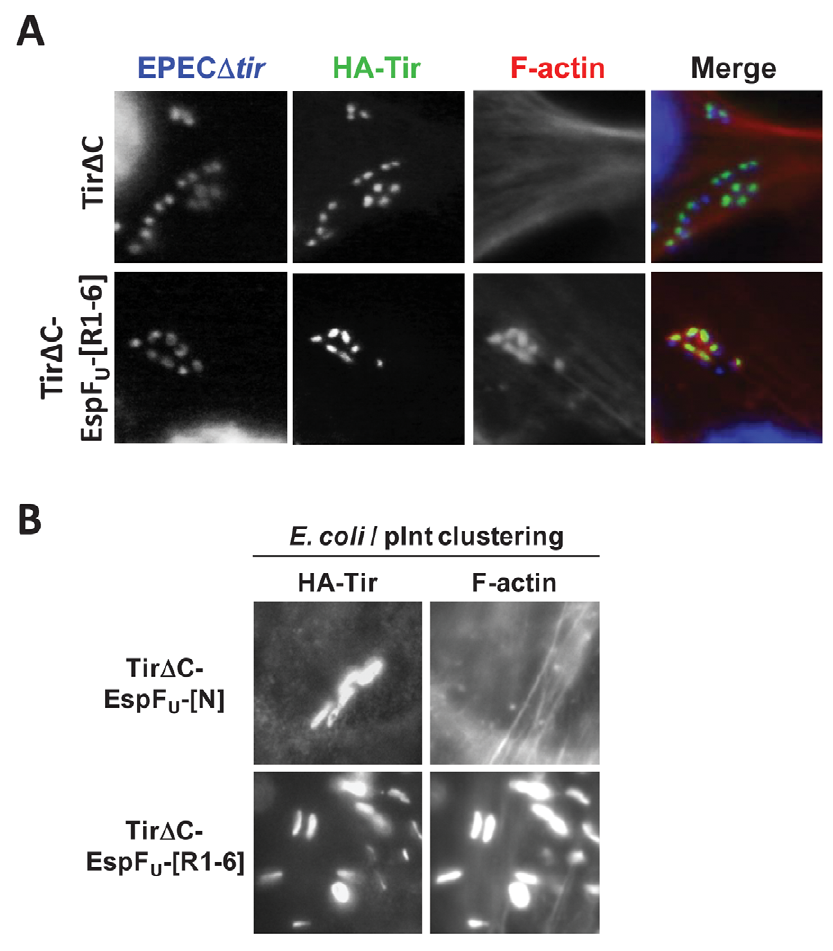
Figure 5. EspF U is necessary and sufficient to drive N-WASP independent pedestal formation. ( A ) NW 2 / 2 FLCs ectopically expressing HA- Tir derivatives in which the C-terminal cytoplasmic domain was deleted (Tir D C) or replaced with the C-terminal repeats of EspF U (Tir D C-EspF U -[R1-6]) were challenged with an EPEC D tir strain (which expresses intimin), and stained with DAPI (blue), anti-HA antibody (green) and Alexa568-phalloidin (red). ( B ) NW 2 / 2 FLCs ectopically expressing HA-Tir derivatives in which the C-terminal cytoplasmic domain was replaced with the N-terminal translocation sequence (Tir D C-EspF U -[N]) as a negative control or the C-terminal repeats of EspF U (Tir D C-EspF U -[R1-6]) were challenged with E. coli / pInt to cluster the fusion protein, and treated as in A